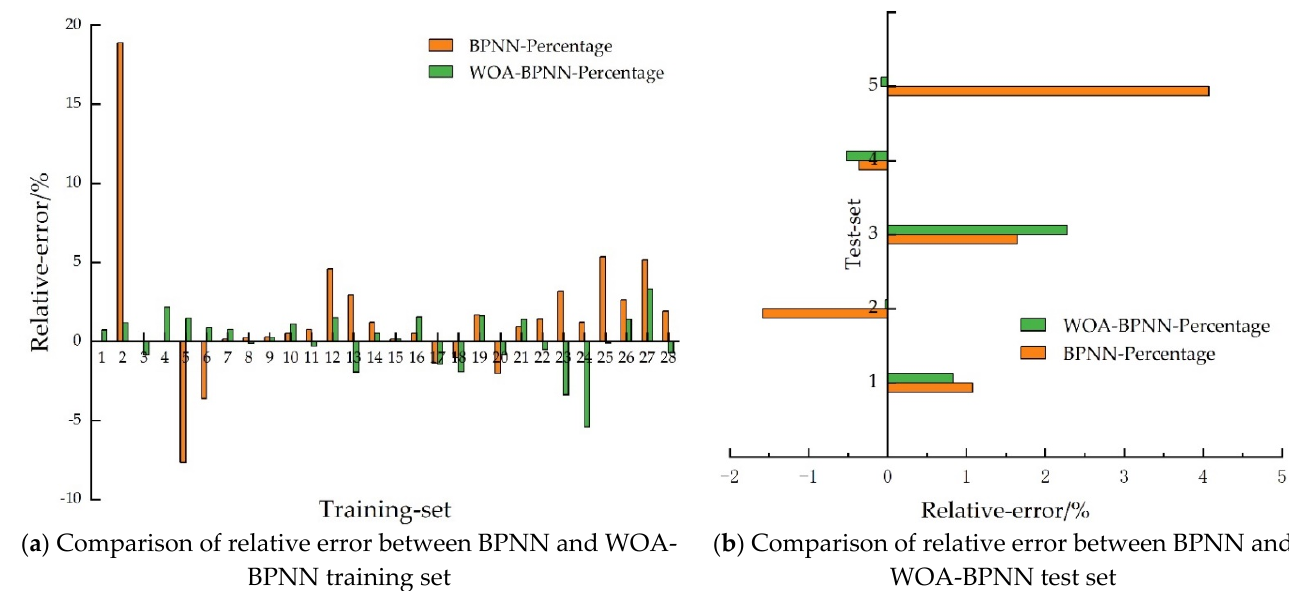
( a ) Comparison of relative error between BPNN and WOA ‐ ( b ) Comparison of relative error between BPNN and BPNN training set WOA ‐ BPNN test set Figure 16. Comparison of relative error between: ( a ) BPNN training value and WOA-BPNN training value. ( b ) BPNN predicted value and WOA-BPNN predicted value.